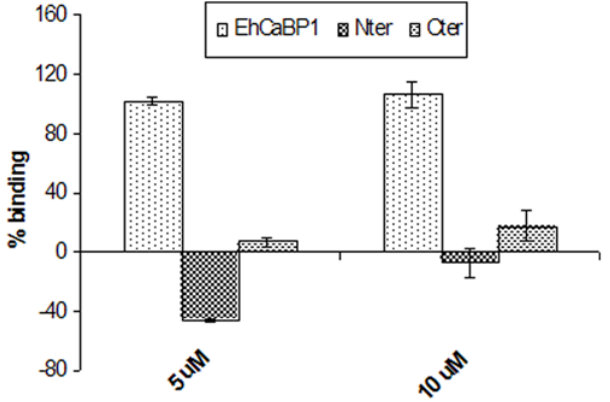
Figure 4. Actin binding properties of EhCaBP1 domains. The ability of the domains to bind G-actin is tested using solid phase assay at different concentrations (5 and 10 m M). The histogram shows the relative mean intensity 6 s.d. of three independent